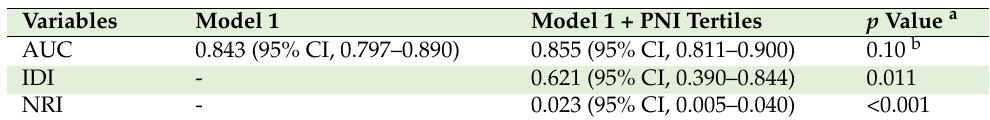
Table 4. Prediction of ESRD among DN